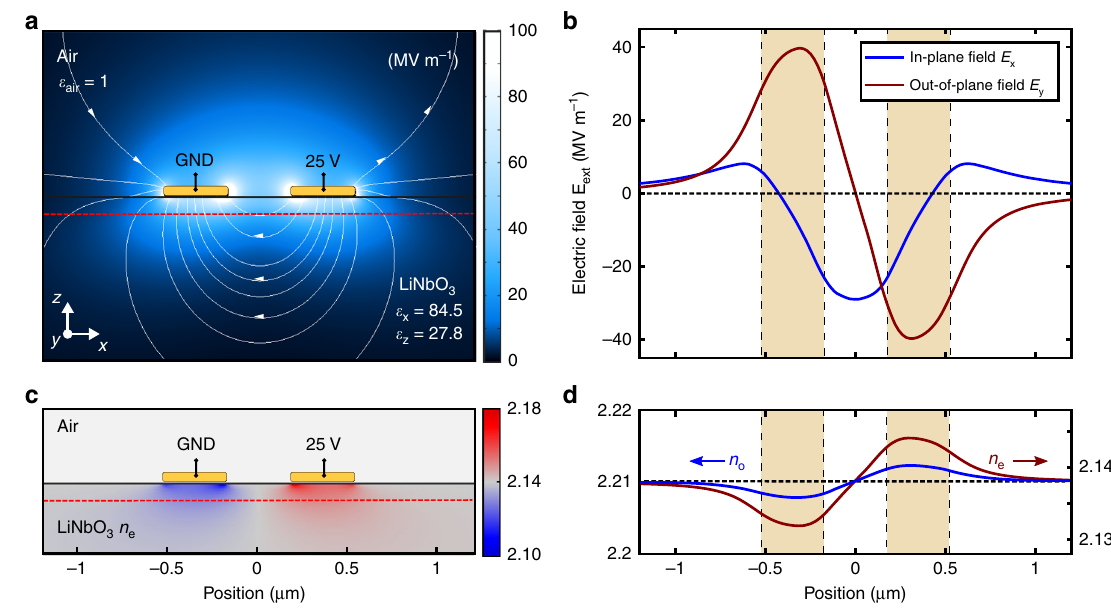
Fig. 2 Electrostatic fi eld simulation of the two-wire con fi guration. a Color-coded electric fi eld and its contours upon applying a bias of 25 V. The electrostatic fi eld extends stronger along the depth-direction ( z -axis), as compared to the isotropic case, due to the anisotropy in the relative permittivity of z -cut lithium niobate (LiNbO 3 , LN). b In-plane ( E x ) and out-of-plane electric- fi eld component ( E z ) in the LN substrate 100 nm below the surface (along the dashed red line shown in Fig. 2a). The yellow bars indicate the position of the Au wires. The in-plane fi eld component E x shows highest amplitude in between the two electrodes, while the out-of-plane component E z exhibits highest amplitude underneath the wires with opposite sign. c , d Due to the linear electro-optic (Pockels) effect in the LN substrate, the extraordinary ( n e ) and ordinary ( n o ) refractive index underneath the left wire is decreased, while being increased by an equal amount in the right guide. Consequently, the waveguides lose their optical identity, which in fl uences the power transfer in the directional